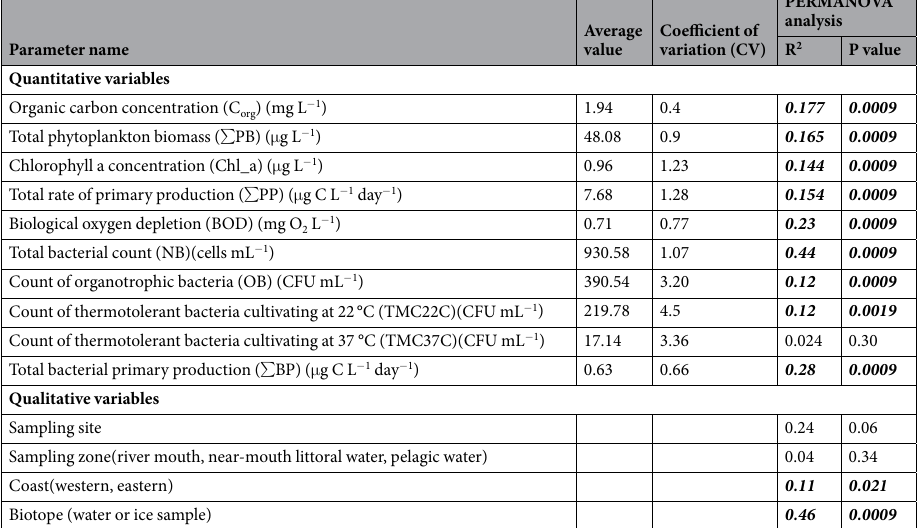
the number of ice samples ( n = 16) was not sufficient for a separate multivariate correlation analysis. Results of the multivariate correlation analysis are shown in Fig. 3 as a heat map. Based on the clustering, several groups of intercorrelated variables were identified. The largest group (cluster A) included hydrochemical parameters such as the P(PO 43 − ), Mg 2 + , Na + , K + , Ca 2 + , HCO 3 − , Cl − ; COD. This group also included biological parameters such as